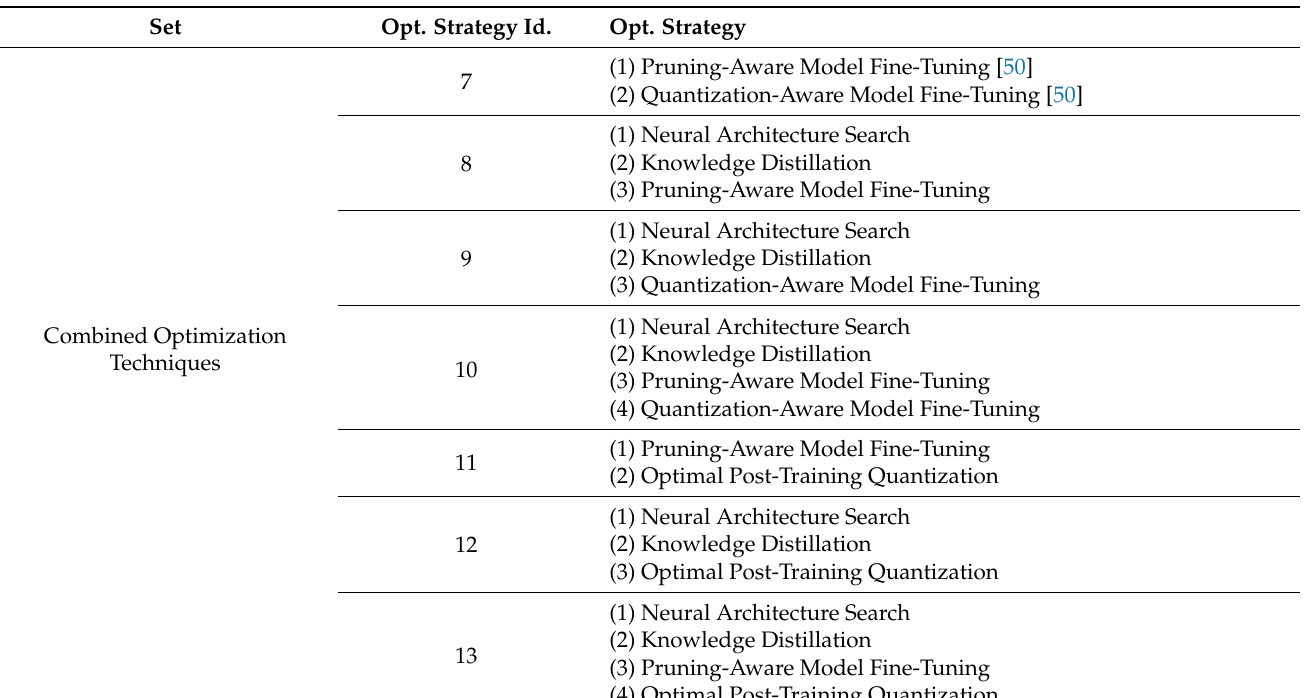
Table 3. Cont. Set Opt. Strategy